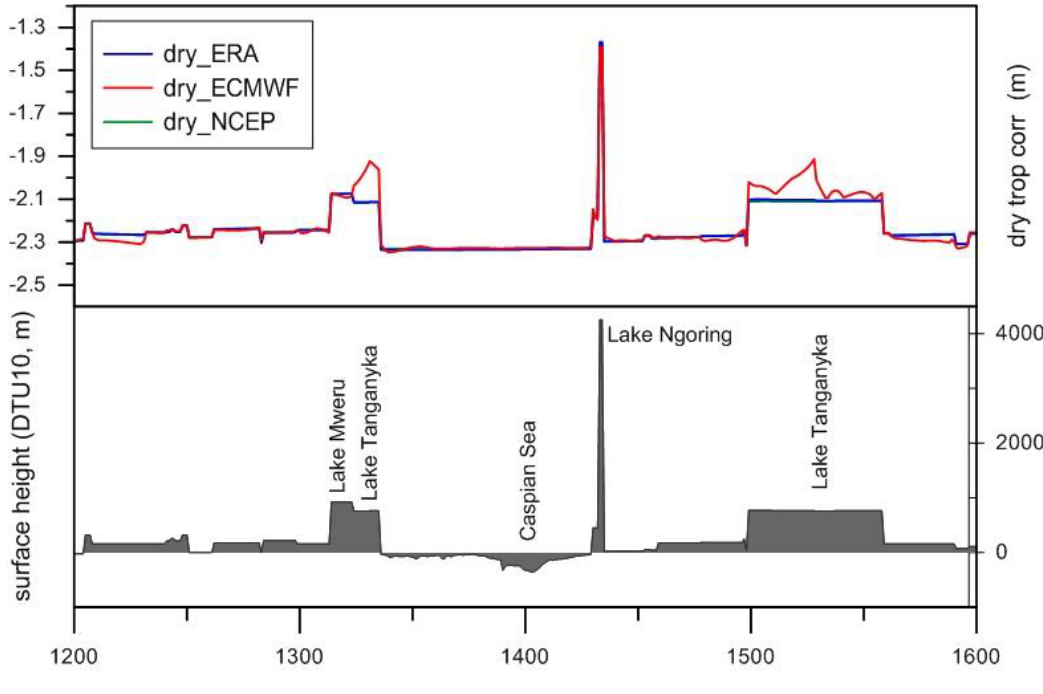
Figure 3. Dry tropospheric correction ( top , in meters) and surface topography from DTU10 ( bottom , in meters) versus the point number by ascending time order, for Jason-1 Cycle 62. Since NCEP and ERA corrections are very similar, when the green line cannot be seen, it is behind the blue